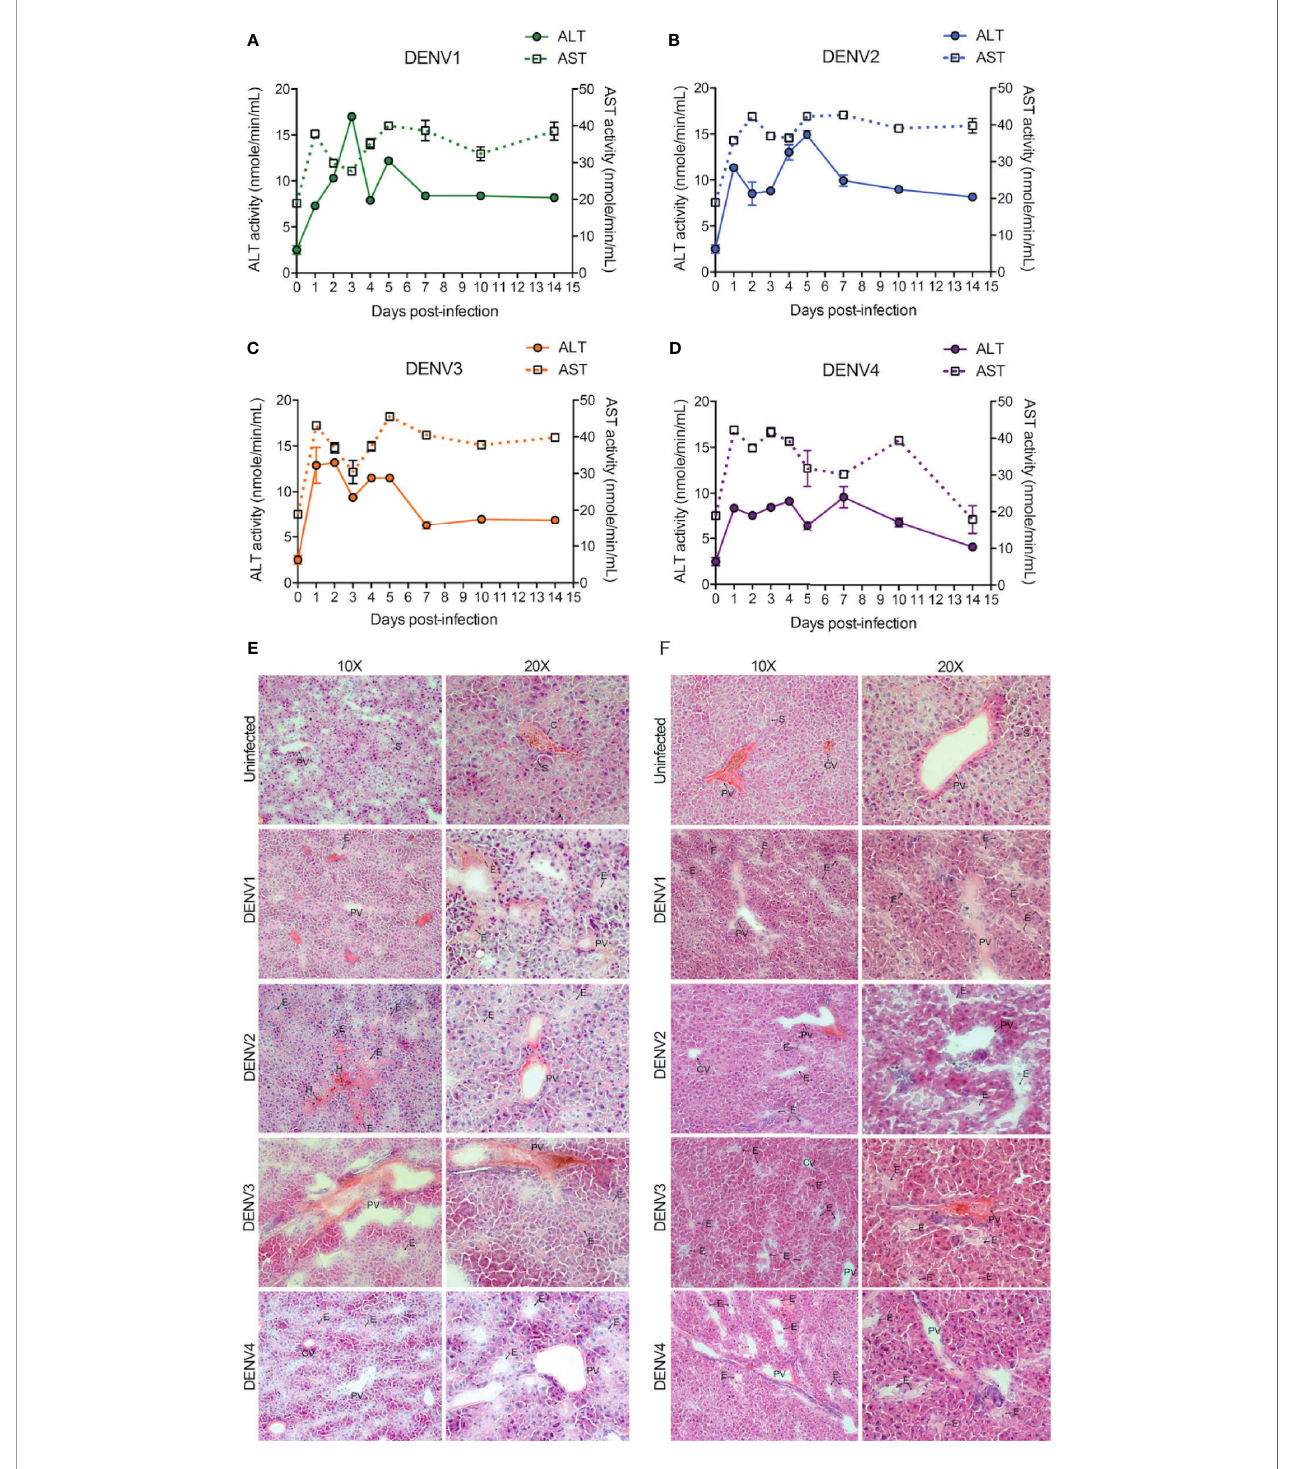
FIGURE 5 | DENV infection causes liver damage in WT mice. (A – D) , Quanti fi cation of functional liver enzymes, alanine transaminase (ALT) and aspartate transaminase (AST) in the mice infected with DENV1-4. The activity levels of both ALT and AST enzymes were elevated up on DENV infection. Baseline values are shown as day 0. (E, F) , shows gross histological observations (hematoxylin and eosin stained sections) where edema (E) was observed in the liver tissues at days 2 (E) and 4 (F) post-infections. Abnormal hemorrhaging (H) and cellular in fi ltrates (*) were also observed for DENV2 infected liver tissues. Central vein (CV), portal vein (PV), and some sinuses (S) are